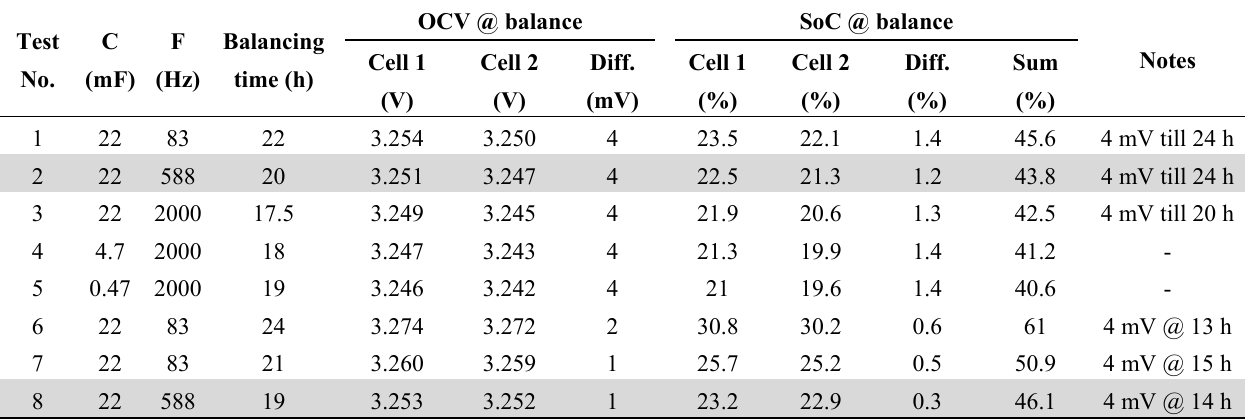
Table 3. Two 2.3 A·h cells balancing experimental testing sequences results using SSC with boosting technique. OCV: